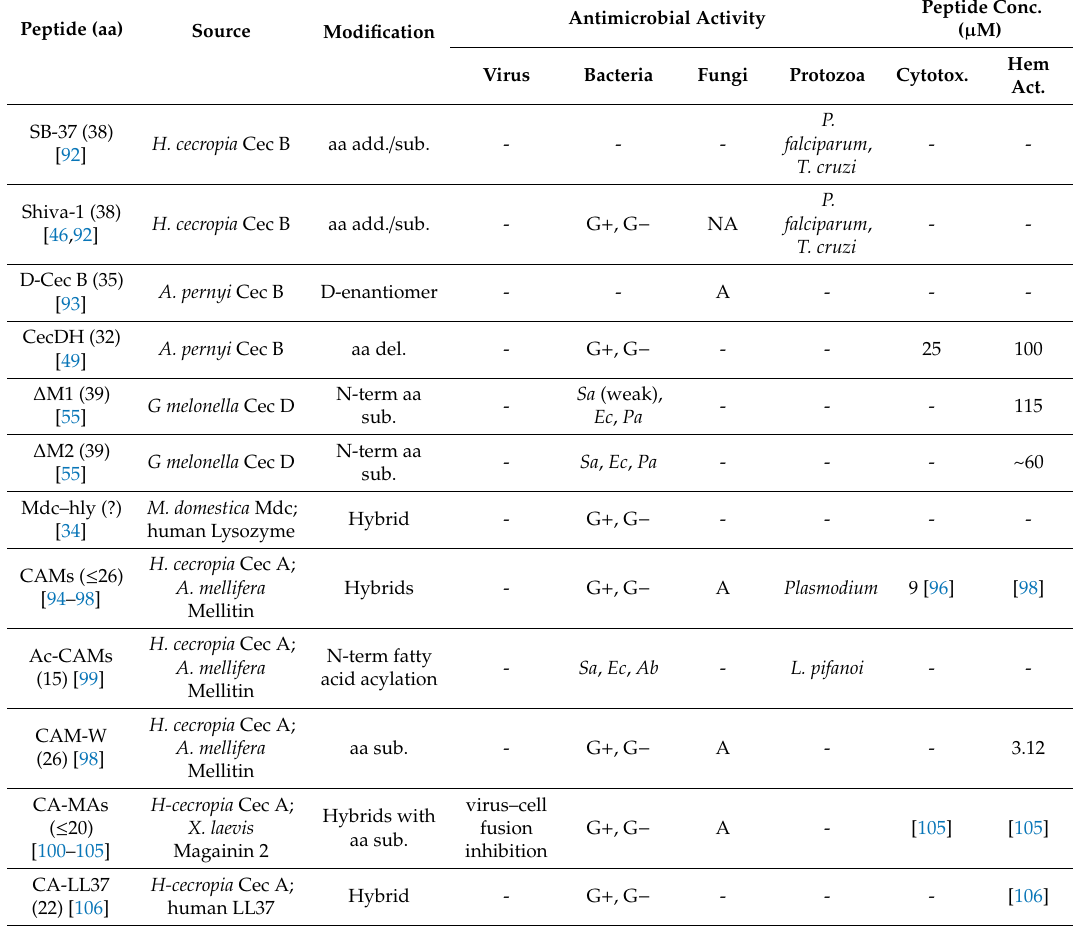
Table 2. In vitro antimicrobial activity and toxicity against mammalian cells of Cec-analogs. Peptide (aa) Source Modification